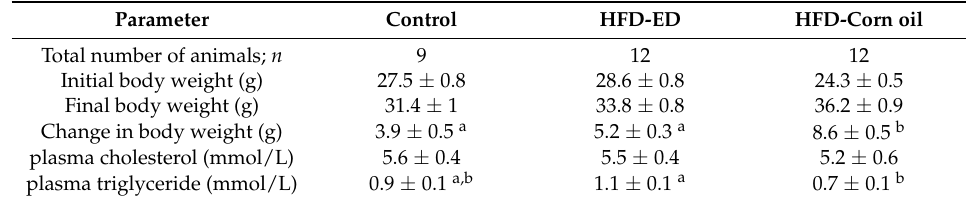
Table 1. Changes in Body Weight Composition and Plasma Lipid Composition.